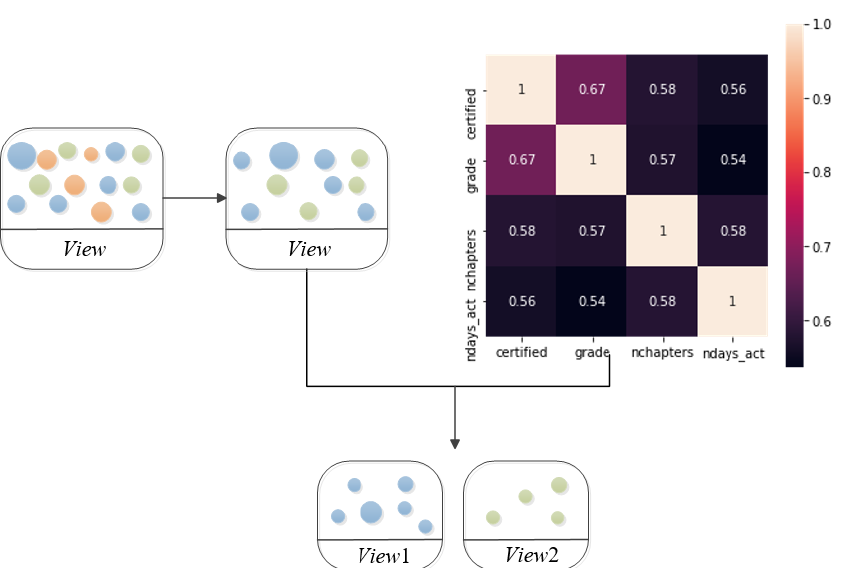
Figure 3. The separation of the remaining features. Orange parts: the important features; blue and green parts: the remaining features, which require to be separated.